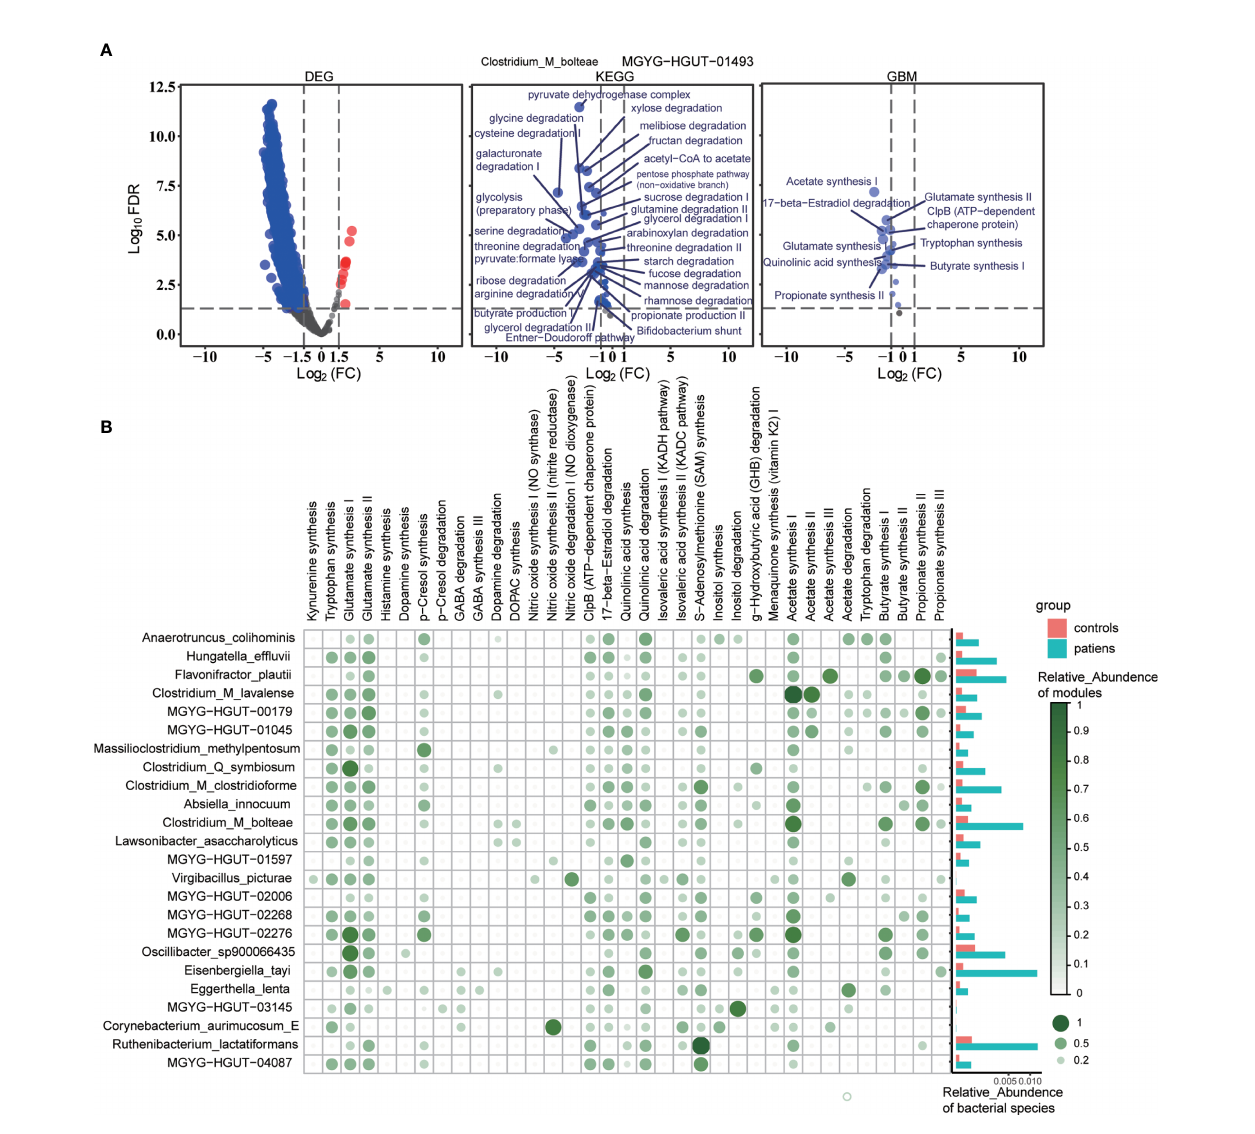
FIGURE 3 | (A) Volcano plots of DEGs, the KEGG modules, and the GBM modules of one speci fi c species of patient group, Clostridium bolteae . DEGs with FDR < 0.05 and |log2FC| > 1.5 and modules with FDR < 0.05 were identi fi ed as differential genes or modules. The modules with |log2FC| > 1 are marked in the fi gure. The blue and red represent the patient group and the control group, respectively. MGYG-HGUT-01493 is the ID of this species in the UHGG database. (B) Dot plot of neuroactive compound metabolism (GBM) of patient group-speci fi c species. The dots mean that species have the metabolic pathway and the bars next to the dot plot mean the relative abundance of this species in each group. The color and size of the dots mean the relative abundance of the metabolic pathway. Each row represents the species, and the column represents the GBM